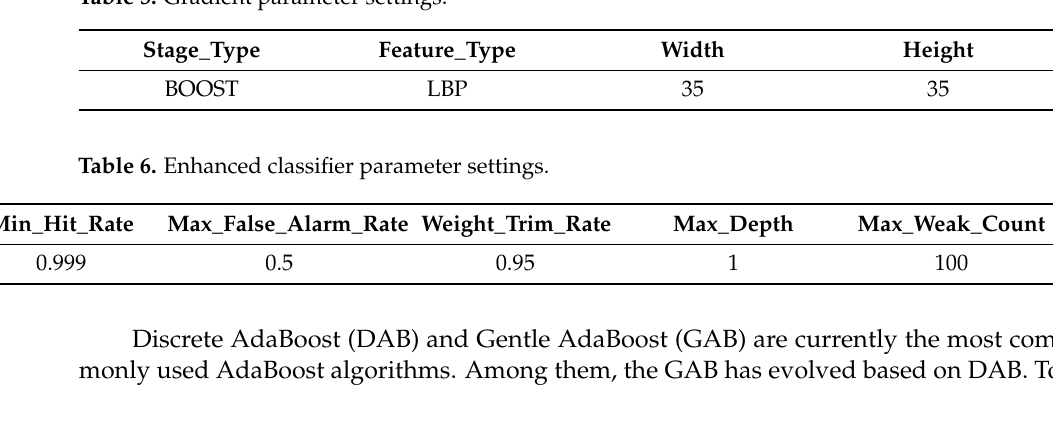
Table 5. Gradient parameter settings.